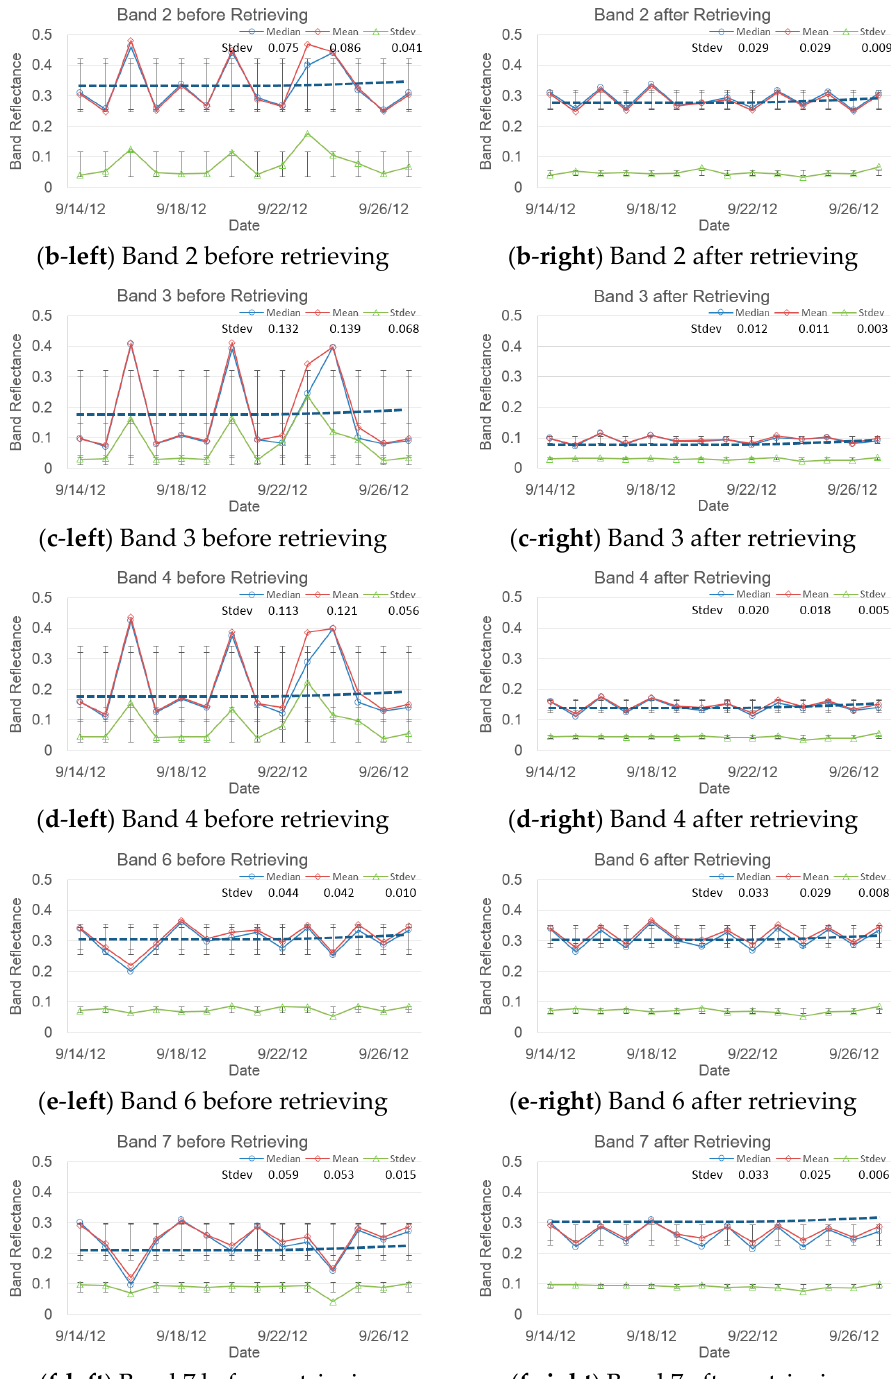
Figure 5. Time series of the median, mean, and standard deviation of the observed spectral reflectance for MODIS bands and the retrieved spectral reflectance for MODIS bands from 14 September to 27 September 2012: ( a – f: left ) the observed spectral reflectance for MODIS bands 1, 2, 3, 4, 6 and 7, ( a – f: right ) the retrieved spectral reflectance for MODIS bands 1, 2, 3, 4, 6 and 7.